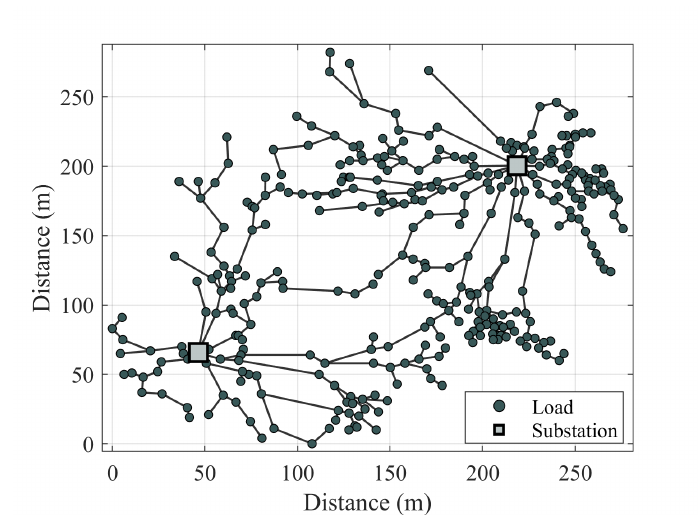
Figure 5. Results of the sectored slime mold in realistic network cases.